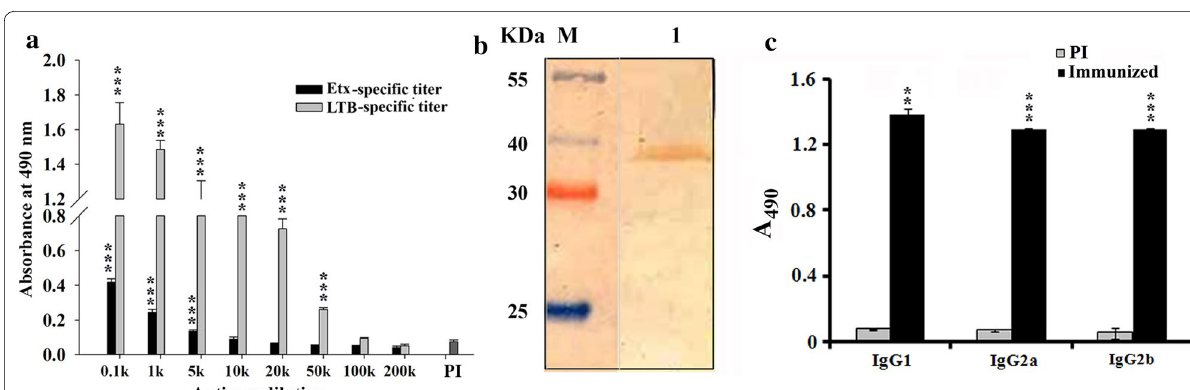
Fig. 4 a Antibody titer of the anti-rLTB.Etx 40–62 antisera against LTB and Etx. ELISA was carried out to determine the LTB-specific and Etx-specific antibody titers in the anti-fusion protein antisera by coating the respective proteins (500 ng/well) as target. Anti-fusion protein antisera (1:2000) was then added followed by the addition of secondary anti-mouse HRP-conjugated antibody. The color was developed by the addition of the substrate OPD and the absorbance was measured at 490 nm. Statistical difference ( p value) was calculated using ordinary two-way ANOVA as compared to preimmune serum (PI). b Immunoblot analysis of the rEtx with the anti-rLTB.Etx 40–62 antisera. Purified rEtx (lane 1) was immunoblotted with anti-rLTB.Etx 40–62 (1:5000 in 1 PBS) antisera. Distinct immunoreactive band indicates that the antibodies present in the anti rLTB.Etx 40–62 antisera are × able to efficiently crossreact with rEtx. Lane M indicates migration of protein molecular weight (kDa). c Antigen-specific antibody isotyping of the anti-rLTB.Etx 40–62 antisera. Different antibody isotypes in anti-rLTB.Etx 40–62 antisera (1:10,000 in 1 PBS) collected on 28 days post immunization were × analyzed by ELISA using biotinylated isotype specific anti-mouse IgG 1 , IgG 2a and IgG 2b (1:5000) secondary antibodies. Pre-immune (PI) sera collected prior to immunization was included as control. Statistical difference ( p value) for each isotype in the anti-fusion protein antisera was calculated using Student’s two-tailed t-test as compared to that measured in preimmune serum (PI). ** p 0.005; *** p ≤ ≤